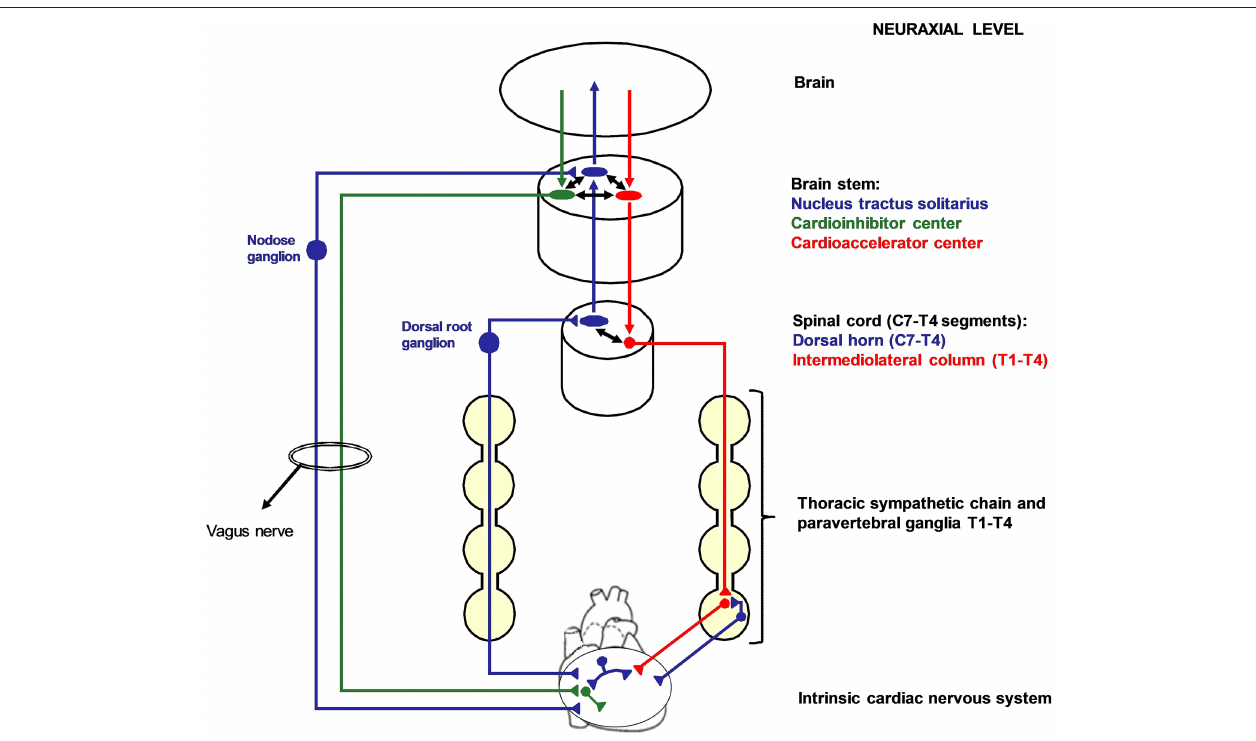
FIGURE 1 | Cardiac nervous system organization in humans. Blue: afferent nervous system with its ganglia: nodose ganglia and C7-T4 dorsal root ganglia (DRG). Green: parasympathetic efferent nervous system. Red: sympathetic efferent nervous system. All the afferent and efferent structures outside the central nervous systems are bilateral, although mostly represented as unilateral for simplicity. Cardiac afferent fibers traveling across the paravertebral sympathetic ganglia (usually referred to as cardiac sympathetic afferent fibers) directly reach the DRG without having synapsis before. These fibers mediate cardio-cardiac sympathoexcitatory spinal reflexes that significantly increase the sympathetic output to the heart. Left cardiac sympathetic denervation (LCSD) consists in the removal of the left thoracic sympathetic chain and paravertebral ganglia from T1 to T4. Since ipsilateral DRG are spared by LCSD, a left afferent reinnervation from the DRG to the heart is theoretically possible with time. On the other hand, the left efferent sympathetic system from T1 to T4 is interrupted at a preganglionic level; therefore, no ipsilateral efferent sympathetic reinnervation is possible after